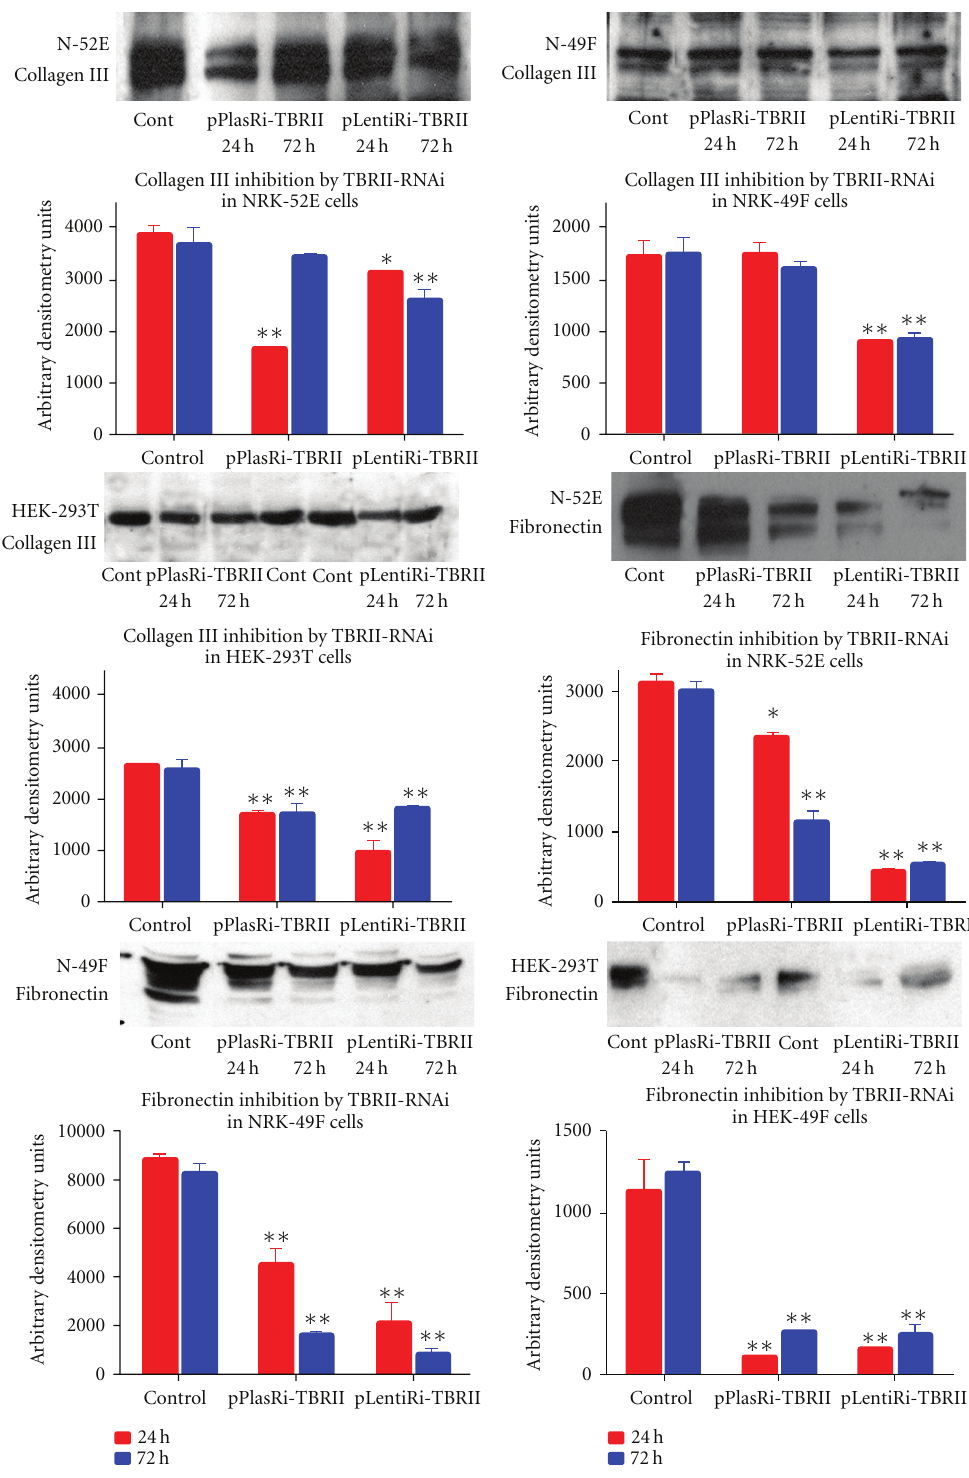
Figure 4: Inhibition of ECM by TBRII RNAi in renal cell lines. Western immunoblots of protein extracts from human embryonic kidney cells (HEK-293T), rat renal fibroblasts (NRK-49F), and epithelial cells (NRK-52E) showed significantly reduced ECM production after TBRII RNAi plasmid transfection (fibronectin is abbreviated as “F’nectin” beside the Western immunoblots). There was significantly decreased collagen III and fibronectin expression post-transfection with pPlasRi-TBRII and pLentiRi-TBRII in NRK-49F and NRK-52E cell lines. In comparison with pPlasRi-TBRII, pLentiRi-TBRII produced a stronger and longer inhibitory e ff ect on collagen III in NRK-49F and on fibronectin in all 3 tested cell lines ( ∗∗ P < . 01 and ∗ P < . 05 in comparison with